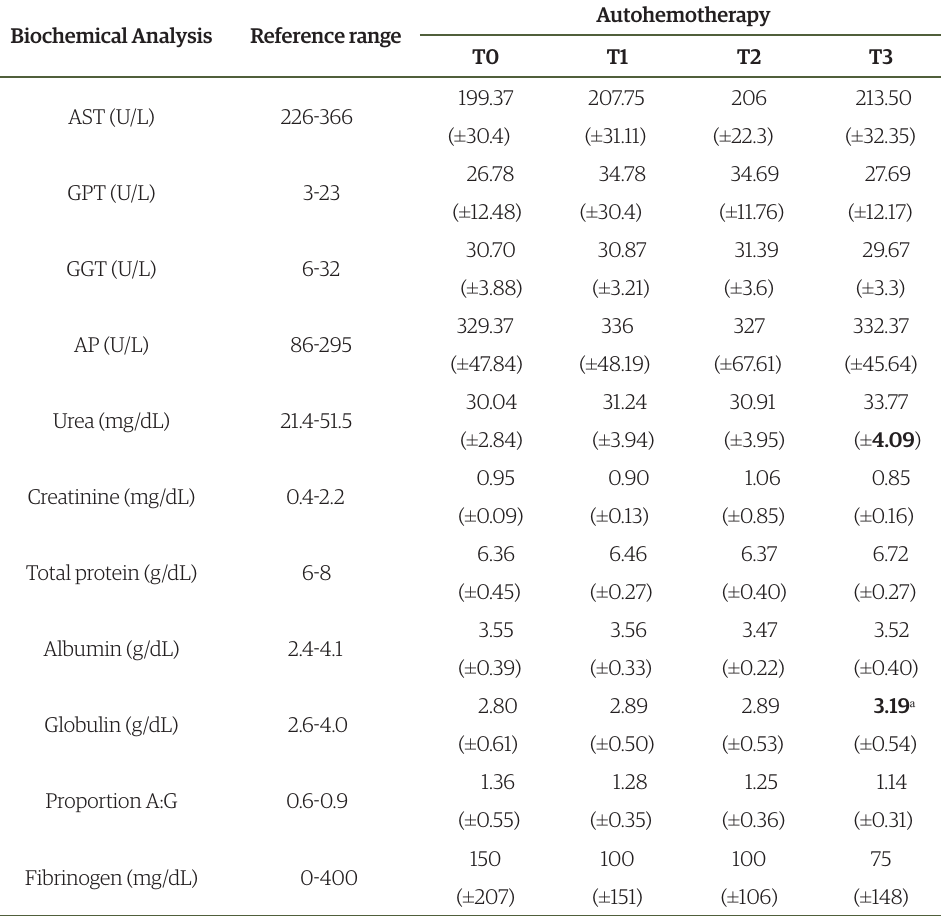
Table 2. Biochemical analysis of the horses submitted to Autohemotherapy over time.